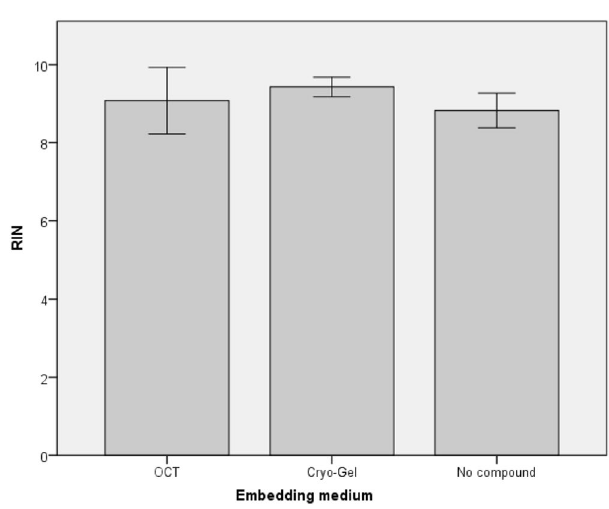
Figure 2. H&E, Jones, PAS, CD31, Trichrome and AE1/AE3 staining on frozen renal tissue samples embedded in Cryo-Gel, OCT and without compound converted to FFPE material (magnification 20x).